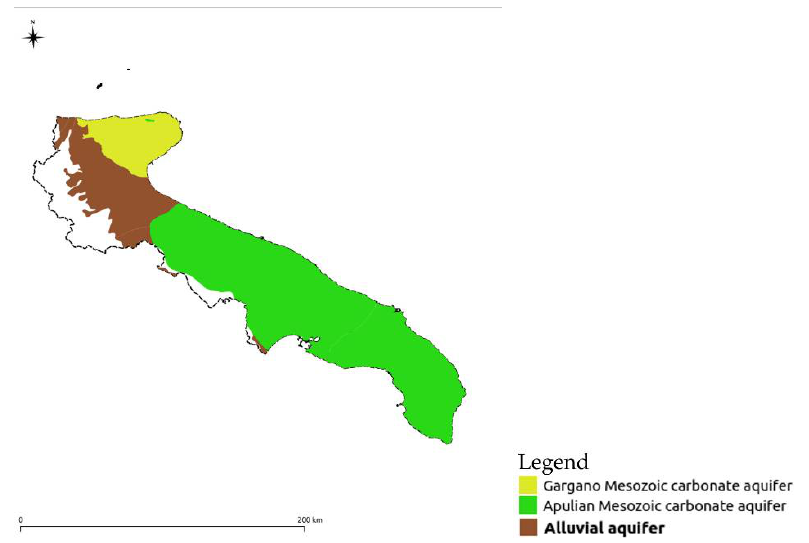
Figure 4. Main subdivision of the aquifers of the Puglia region. Table 1. Classification adopted by the application of the DRASTIC model for the three macro-areas aquifers of Puglia Region (shown in the table by adimensional numbers).